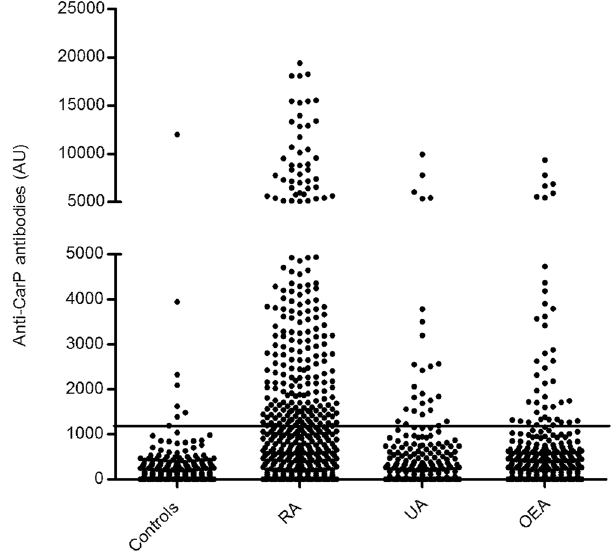
Figure 1. Titers of anti-CarP antibodies in the EA patients and healthy controls. The EA patients were stratified according with their classification at the end of the two year follow-up in RA, undifferentiated arthritis (UA) and other EA (OEA). Each dot represents the anti-CarP titer of a subject. The horizontal line is the threshold for positivity. The Y axis break separates two sections with different scaling without solution of continuity.